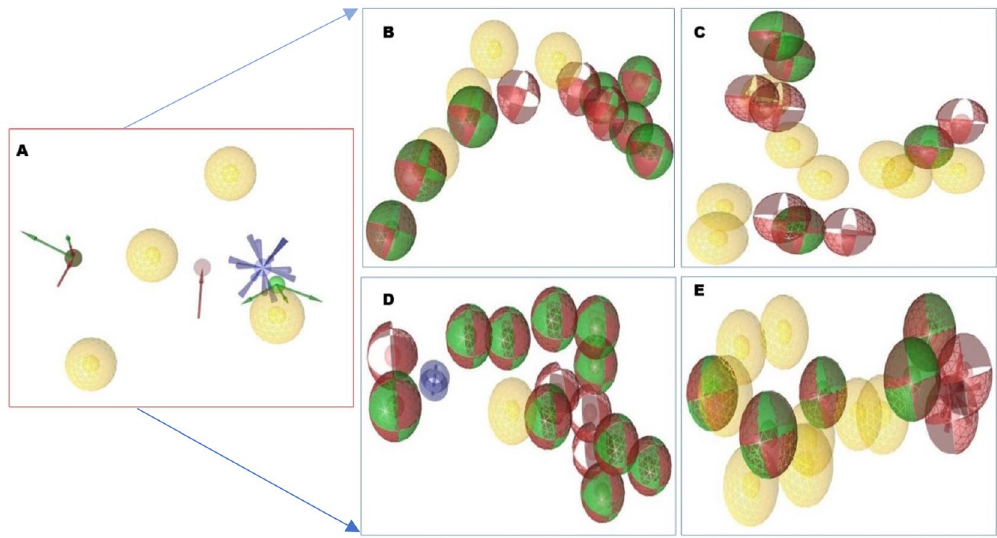
Figure 7. Pharmacophore features generated from the four selected compounds attach to the desire XIAP protein. Ligands attach to the protein ( A ) 46781908 had four hydrophobic (yellow), one positive ionizable (blue star), three H bond acceptor (red), and five hydrogen bond donors (green) pharmacophore features. Comparing to this most of our selected compounds ( B ) ZINC77257307, ( C ) ZINC1070004335, ( D ) ZINC247950187 and